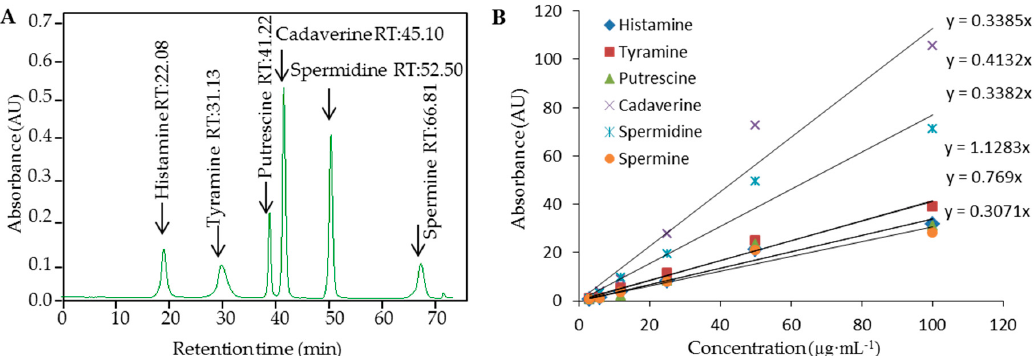
Figure 2. ( A ) Typical IE chromatogram of standard solution composed of selected BAs (100 µg·mL − 1 ); ( B ) Calibration curves measured under the optimal conditions are shown for Histamine, Cadaverine, Tyramine, Spermindine, Spermine, and Putrescine.